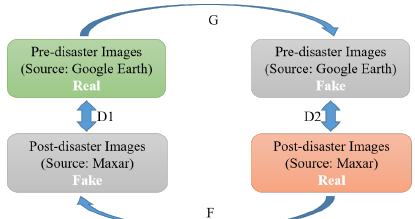
Figure 3. The CycleGAN structure to implement color style transfer. G and F: generators. D1and D2: